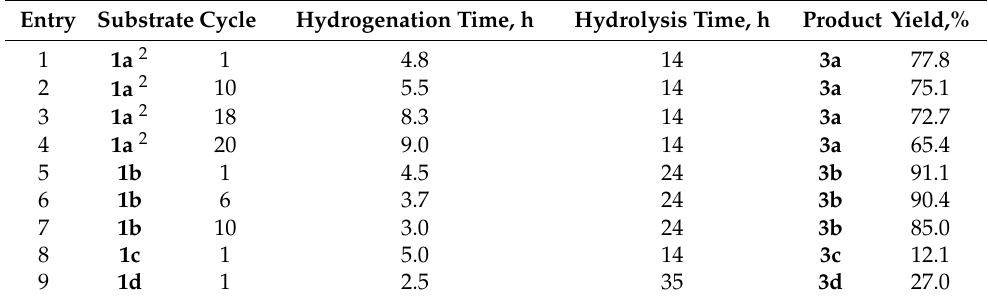
Table 3. Hydrogenation results for substituted trinitrobenzenes in aqueous acetone followed by hydrolysis 1 .